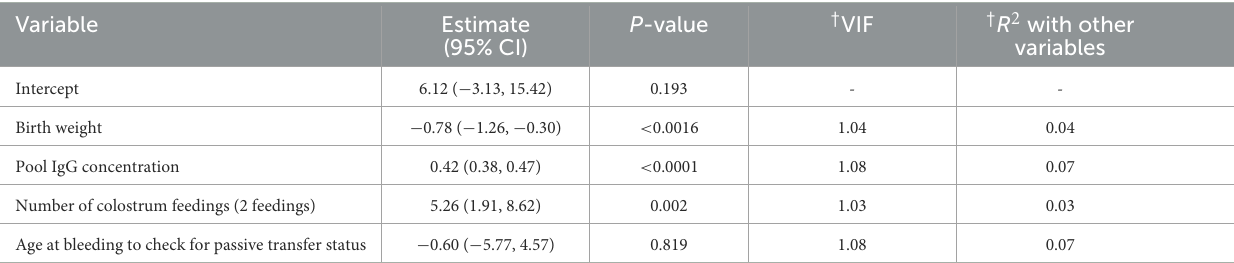
TABLE 2 Summary of multivariable linear regression model predicting calf serum IgG concentrations as a continuous variable at 24–72h in 164 Jersey calves fed various pools of